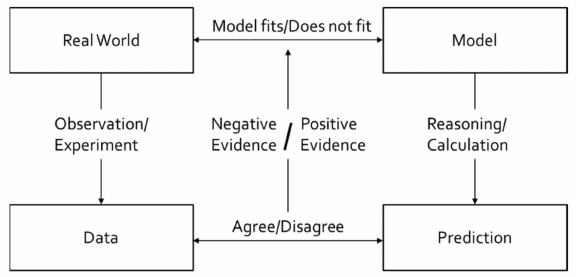
Figure 1. Scientific reasoning model (redrawn from